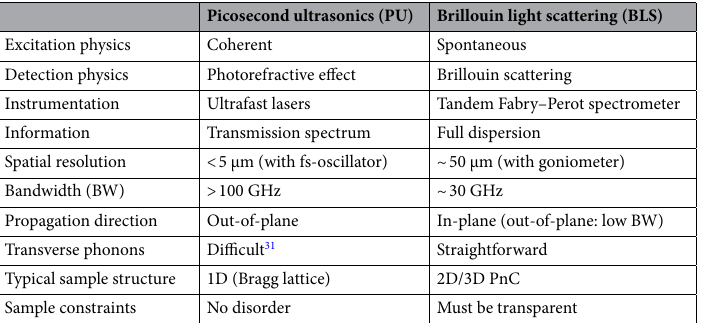
Table 1. Comparison of typical time- and frequency-domain characterization methods for phononic bandgap structures. Hybrid pump–probe spectroscopy inherits most of the performance characteristics (except BW) from PU, while obviating the sample constraints of both